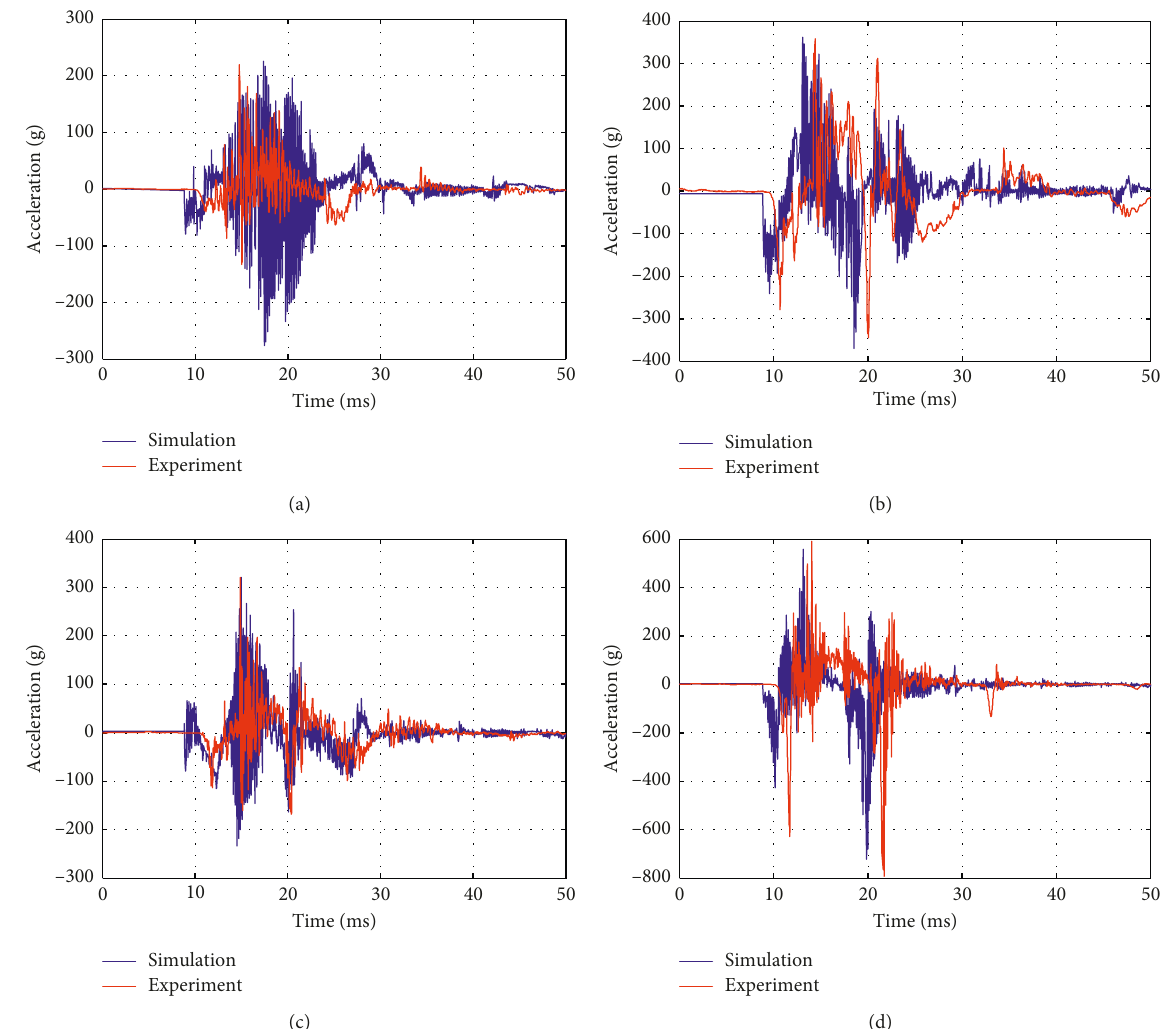
Figure 12: Acceleration response curves of test and simulation. (a) Thin wall with a thickness of 0.2mm, (b) thin wall with a thickness of 0.3mm, (c) thin wall with a thickness of 0.4mm, and (d) FTS with a thickness of 0.2 mm.